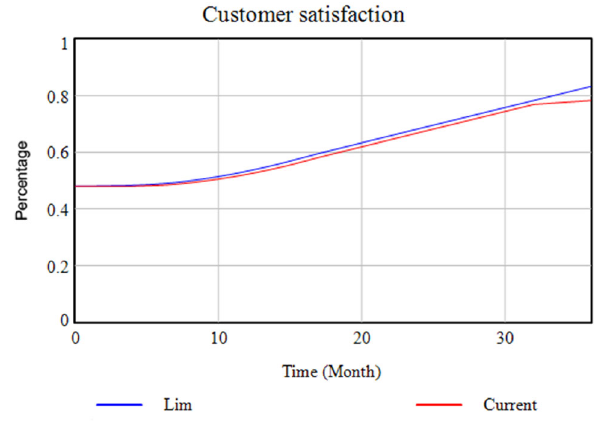
Fig. 8 The effect of eliminating the supplier risk on profits